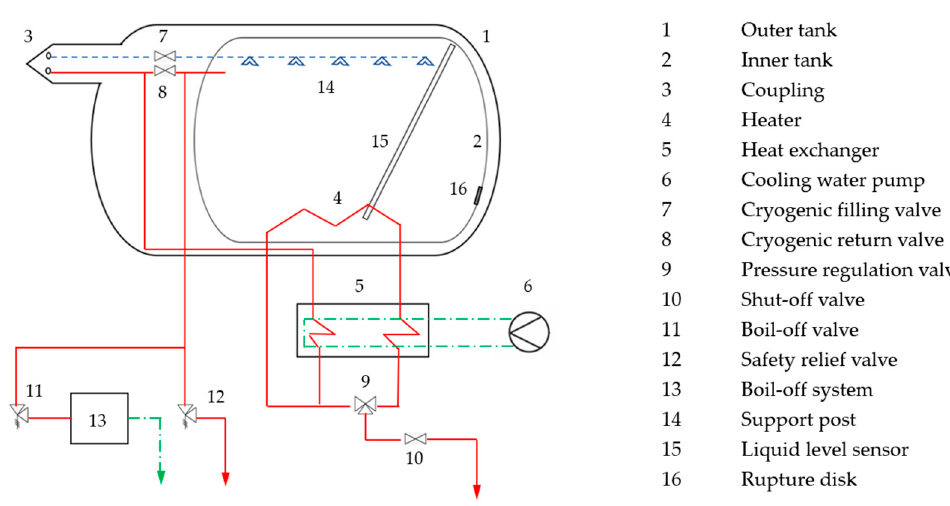
Figure 2. Cryogenic tank for onboard storage of liquid hydrogen (adapted from